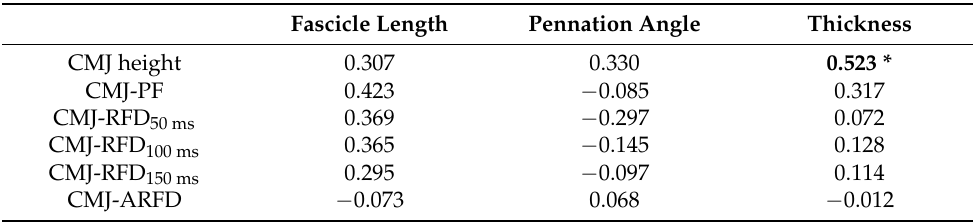
Table 3. Correlation coefficients (Pearson’s r ) between VL muscle architecture and CMJ force–time characteristics (n = 19).